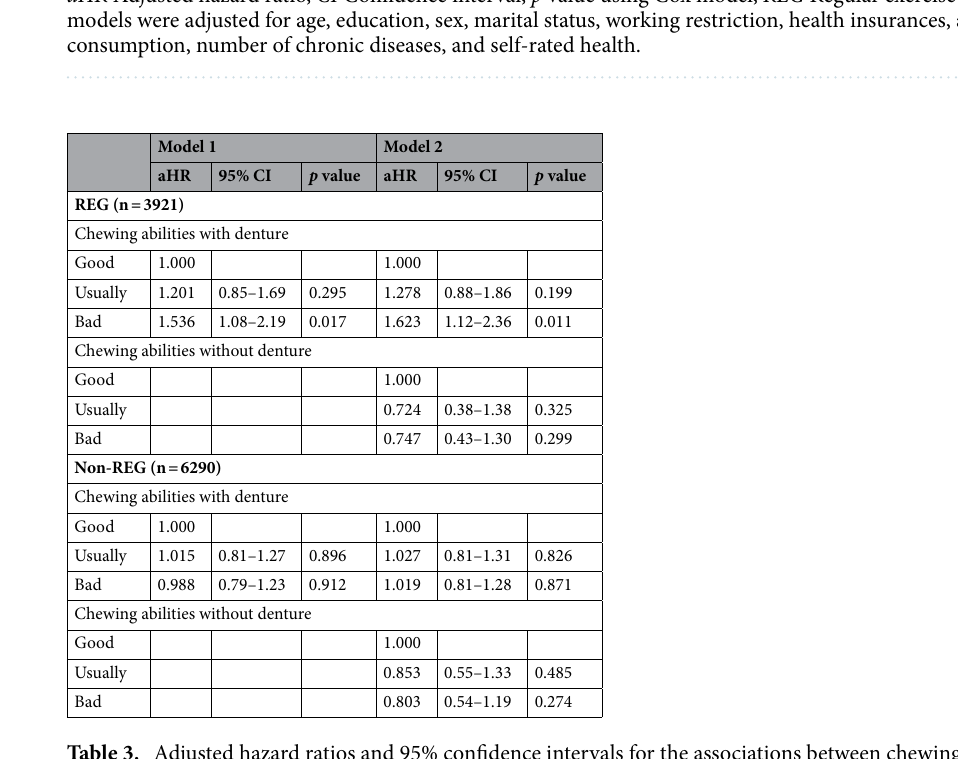
Table 3. Adjusted hazard ratios and 95% confidence intervals for the associations between chewing abilities and all-cause mortality in the denture wearing group from the Korean Longitudinal Study of Aging 2006–2018. aHR Adjusted hazard ratio, CI Confidence interval, p value using Cox model, REG Regular exercise group. All models were adjusted for age, education, sex, marital status, working restriction, health insurances, alcohol consumption, number of chronic diseases, and self-rated